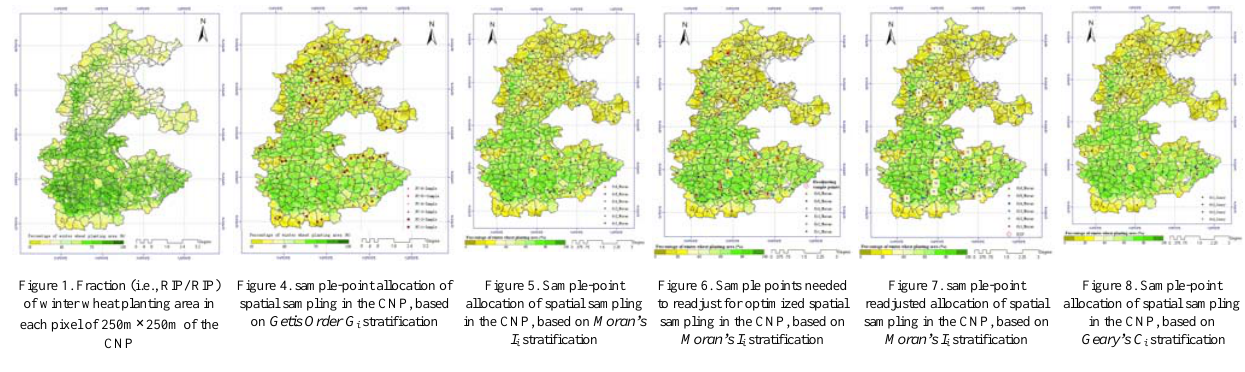
Figure 1. Fraction (i.e., RIP/ RIP) Figure 4. sample-point allocation of of winter wheat planting area in spatial sampling in the CNP, based on Getis Order G i stratification each pixel of 250m × 250m of the CNP